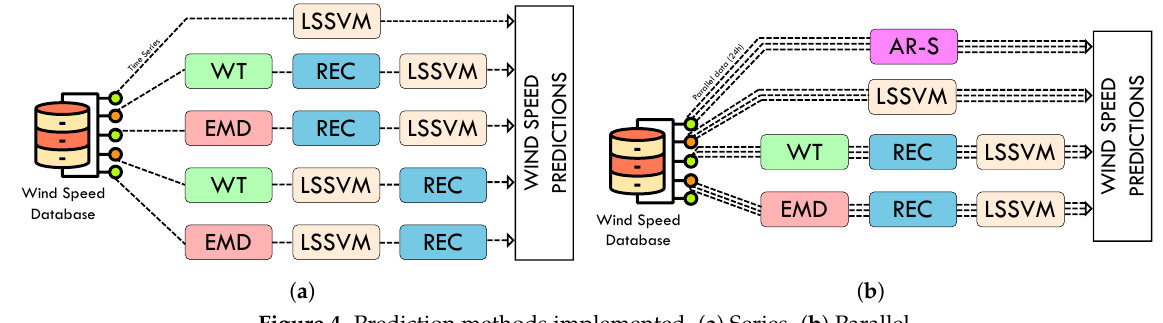
Figure 4. Prediction methods implemented. ( a ) Series. ( b ) Parallel.